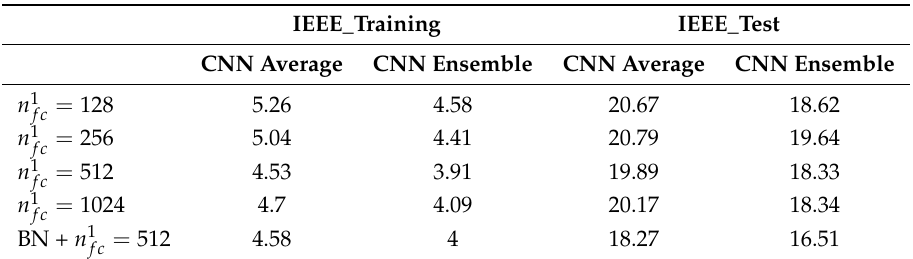
Table 5. Evaluation of size of the first fully connected layer ( n 1 and ensemble prediction results are given, based on the 7 repetitions.